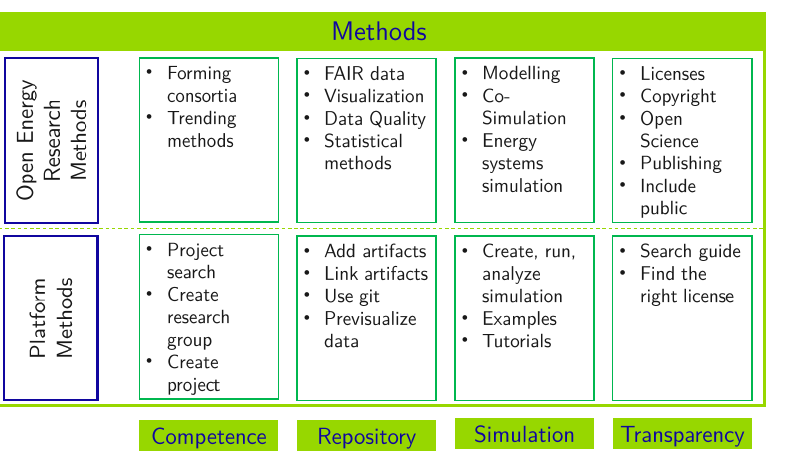
Figure 4. Overview of Methods